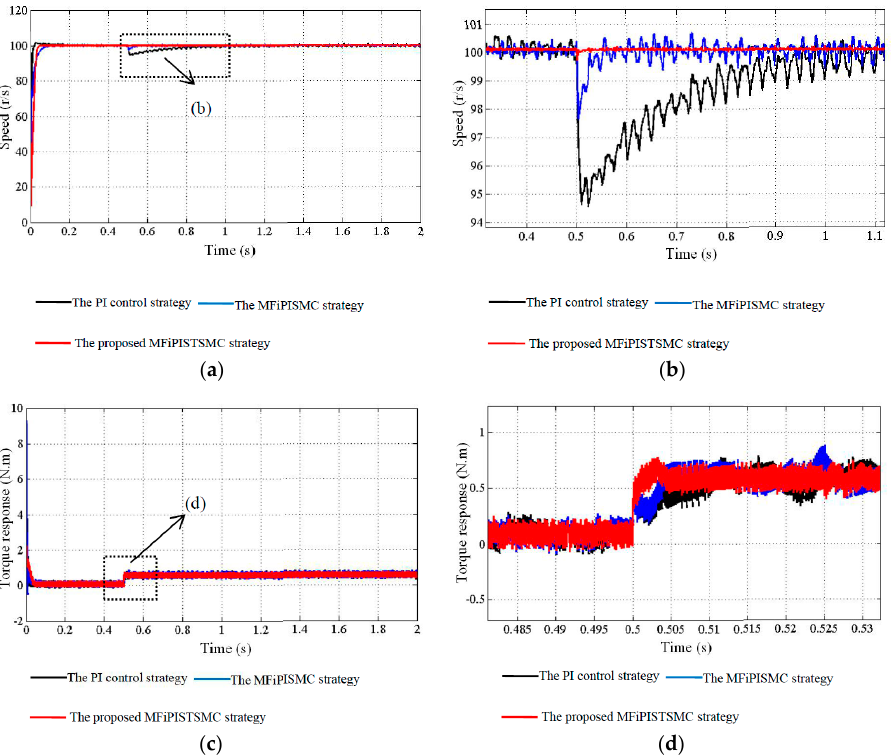
Figure 5. ( a ) Speed response curves with load increased suddenly; ( b ) detailed view of the image ( a );